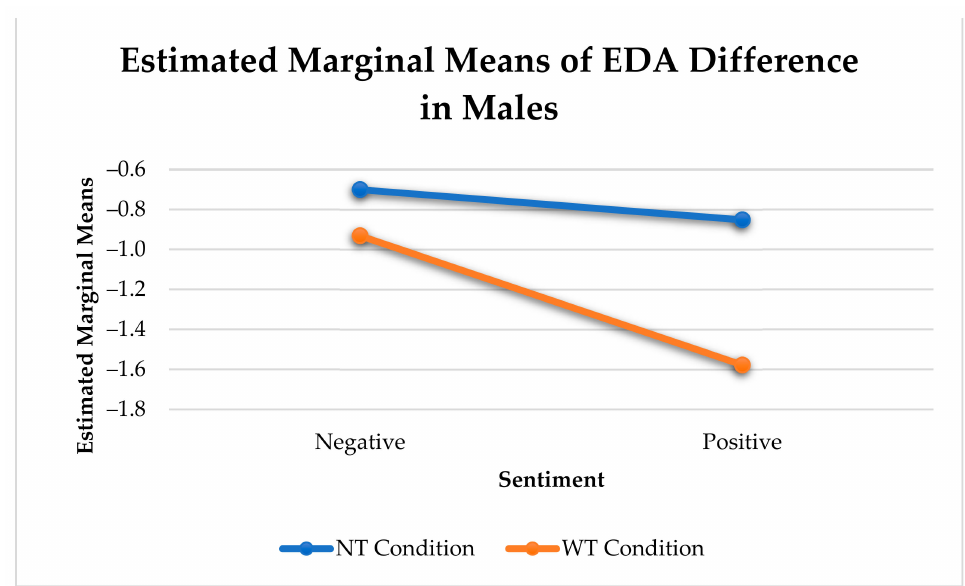
Figure 12. Differences in Physiological Arousal Change Elicited by Utterances with or Without Affective Touches for Positive and Negative Sentiment in Males.